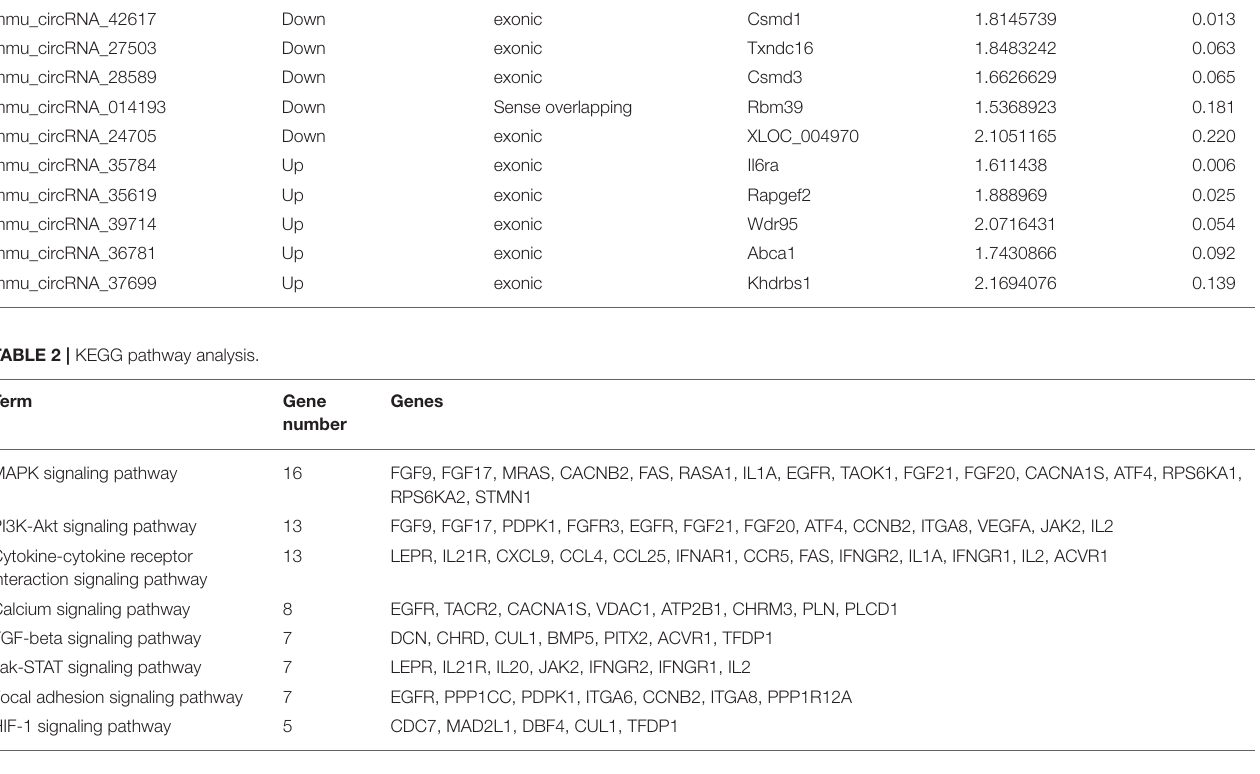
TABLE 1 | Selected significantly differentially expressed circRNAs in AS mice. circRNA